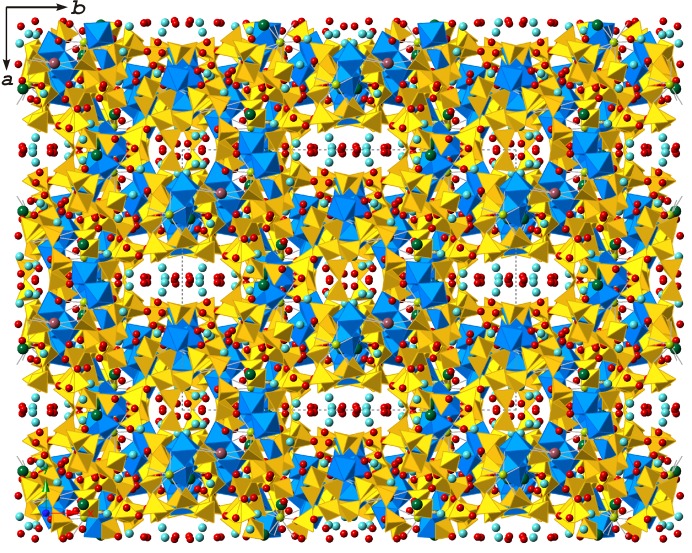
Projection of the crystal structure of ilmajokite along the c axis. Legend: Si tetrahedra – yellow, Ti octahedra – blue; H2O molecules, Na, K, Ba and Ce atoms are shown as red, light-blue, green, brown and orange spheres, respectively.